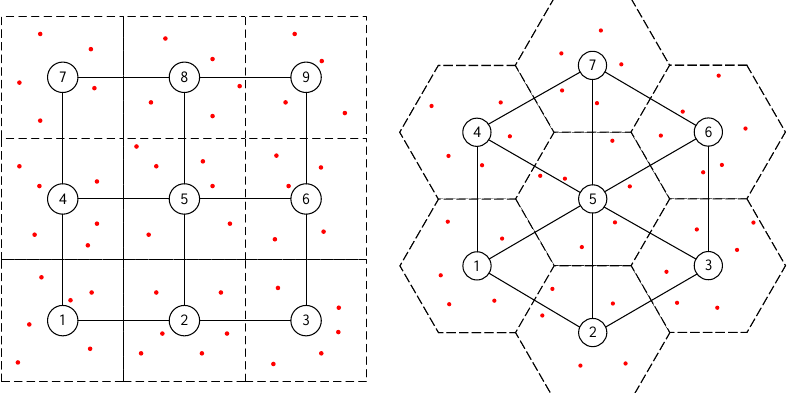
Figure 2. The configurations of the UAV-assisted ad hoc networks using square cell and hexagonal cell coverage